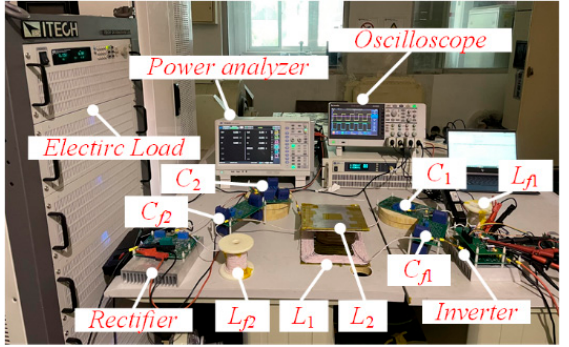
Figure 8. Fundamental prototype of a DWPT system.